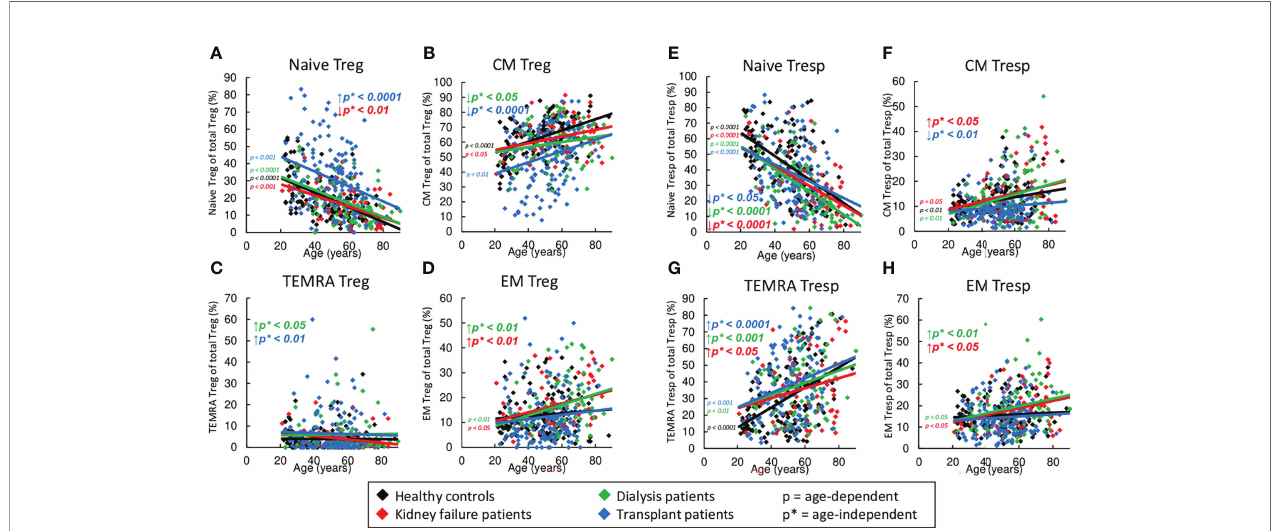
FIGURE 3 | Differentiation of CD8 + Tregs and CD8 + Tresps in healthy controls (n=134), KF patients (n=57), dialysis patients (n=87), and kidney transplant patients (n=138). The fi gures present the percentages of naïve (A, E) , CM (B, F) , TEMRA (C, G) , and EM Tregs/Tresps (D, H) within total Tregs/Tresps of healthy volunteers ( ♦ ), KF patients ( ♦ ), dialysis patients ( ♦ ), and kidney transplant patients ( ♦ ). Regression lines concerning changes with age are shown for both healthy volunteers and all patient groups. Signi fi cant changes are marked by color-matched p-values. Age-independent signi fi cant differences between healthy volunteers and study groups are marked by an arrow ( ↑↓ ) and their color-matched